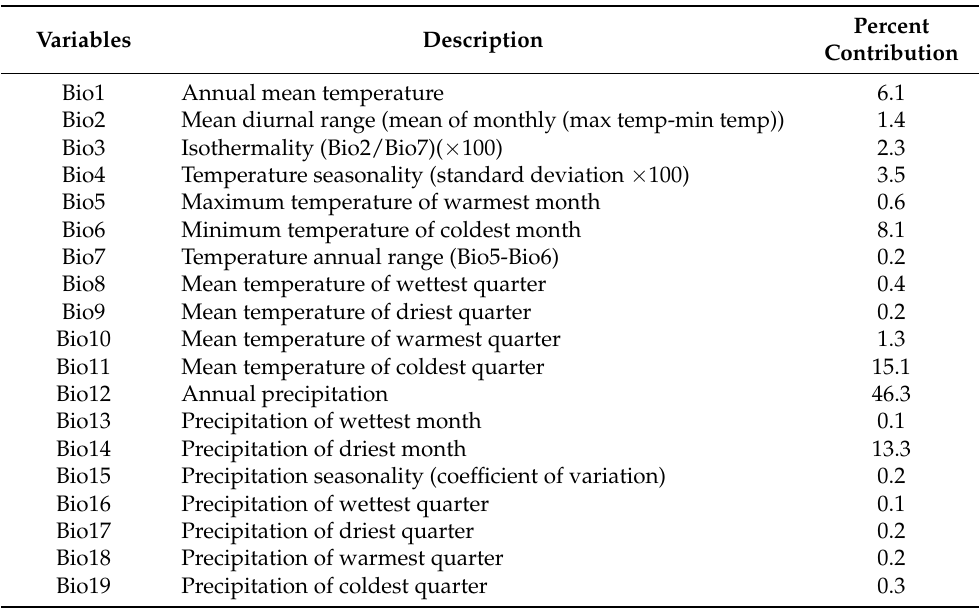
Table 1. Bioclimatic variables utilized in the model and the proportional contributions of 19 biocli- matic factors to the Maxent model for